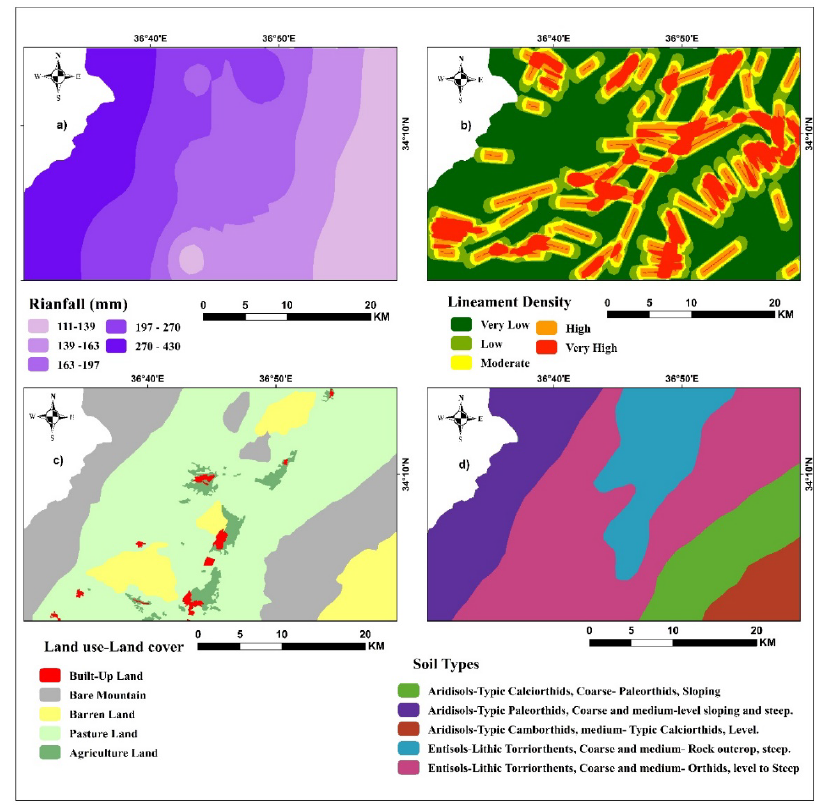
Figure 6. ( a ) Rainfall, ( b ) Lineament density, ( c ) LULC, and ( d ) Soil. The rate of infiltration is determined by the porosity of the soil type [98], which is controlled by the amount of groundwater recharge. The soil types of the study area are listed in Table 6. Based on the infiltration rate of each soil, the highest overall score was assigned to type Entisols-Lithic Torriorthents, Coarse and medium- Orthids, level to Steep based. Figure 6d shows a soil map of the study area. Table 6. Weight and scores of specific characteristics that were assigned to factors that influence GWPZ. Factors